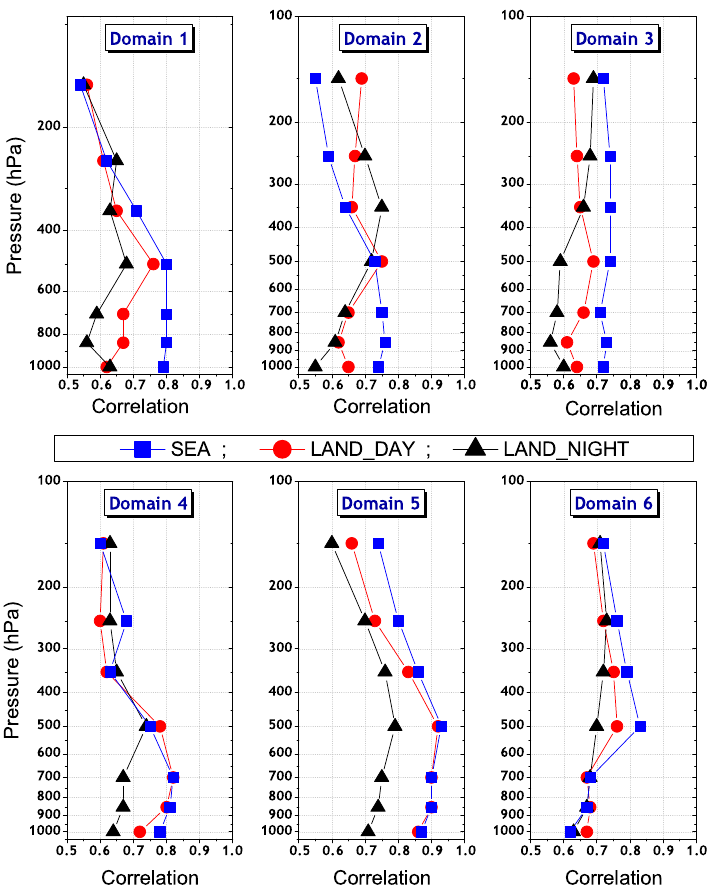
Figure 9. Same as Fig. 8 but for the correlation coefficient between CO vertical profiles deduced from MOPITT CO TOTCOL_ANALYSES and the MOPITT V3 observations. The comparison is made for each level of the MOPITT V3 retrievals.